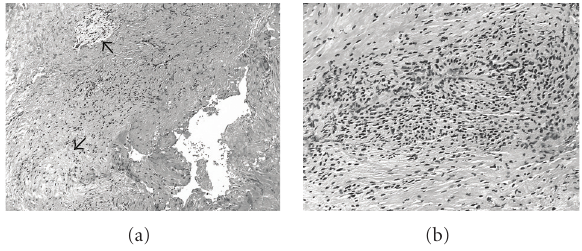
Figure 2: Hemotoxylin and eosin stained biopsy sections reveal (a) focal stromal myxoid changes (arrows), mild inflammatory infiltration, fibrosis, and (b) areas of synovial